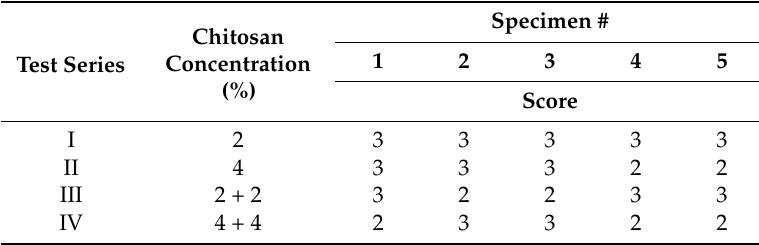
Table 2. Scoring of the adhesion strength of chitosan to the underlying